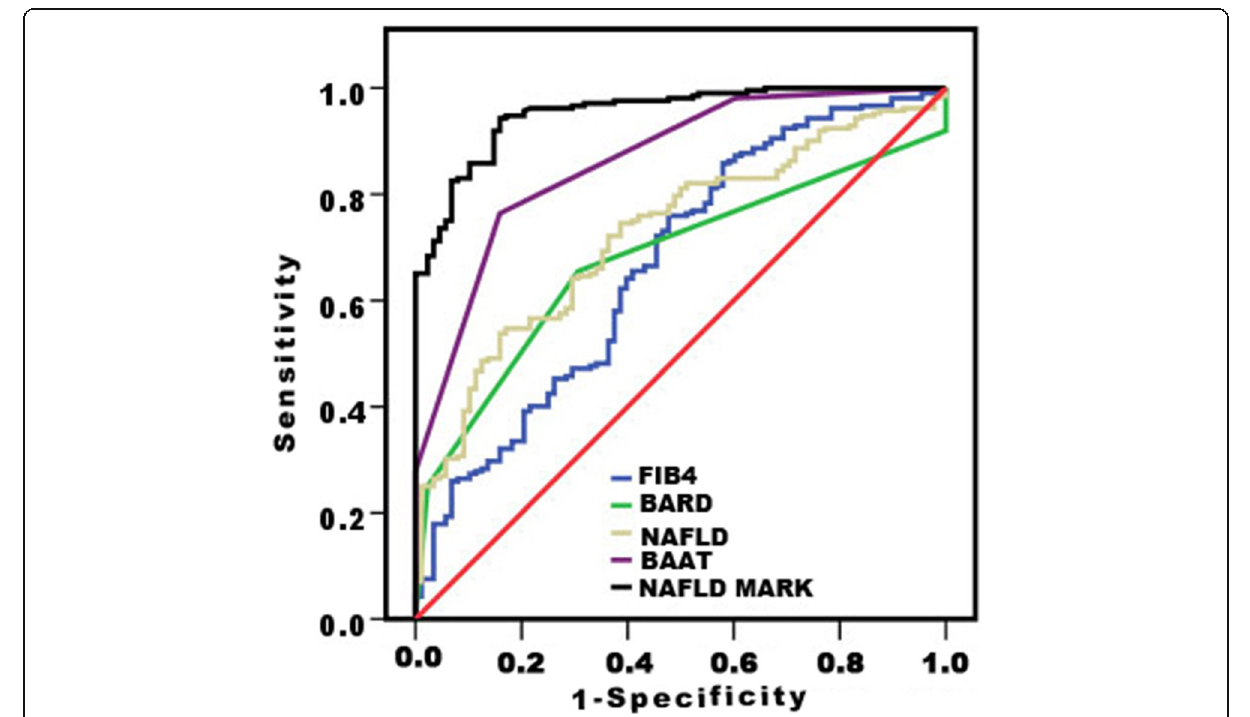
Fig. 2 Evaluation of diagnostic performance of NAFLD mark vs non-invasive models for NAFLD using area under ROC